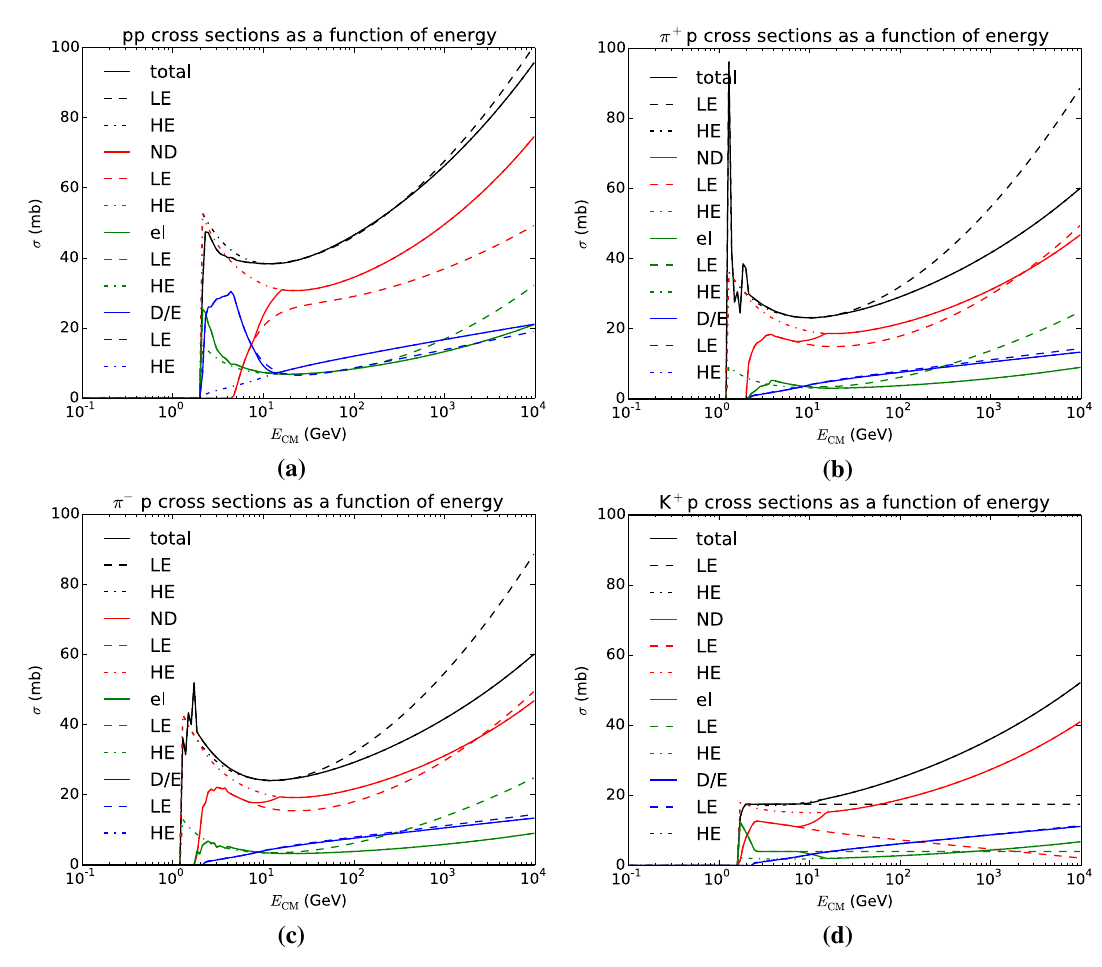
energy (HE) separate inputs. The LE/HE curves are shown also outside of their regions of intended validity, so should be viewed as illustrative